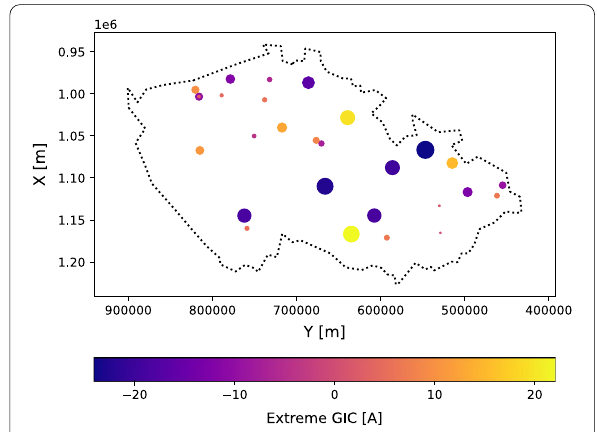
Fig. 8 Expected GICs in the studied substations with the 1-V/km eastbound electric field